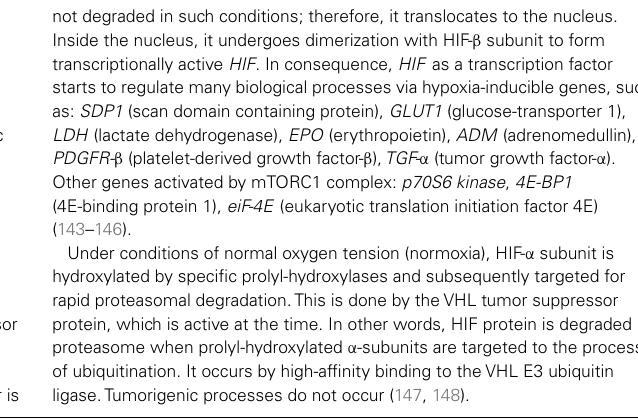
FIGURE 1 | Hypoxia inducible factor and VEGF link the HIF/VHL and PI3K/Akt/mTOR signaling pathways .Vascular endothelial growth factor, together with other external growth factors, activates Akt , which in turn activates mTORC1 complexThe PI3K (phosphoinositide 3-kinase) pathway may be overactive because of faulty or deficient phosphatase and tensin homolog ( PTEN ). mTORC1 is a protein complex that functions as a specific controller of protein synthesis. It is composed of mTOR itself, a regulatory-associated mTOR protein named Raptor, mammalian lethal with SEC13 protein 8 (MLST8) and G β L, a positive regulator of the rapamycin-sensitive pathway required for the nutrient-sensitive interaction between Raptor and mTOR.What is striking is that it has been shown that mTORC1 complex, when up-regulated, subsequently up-regulates the expression of HIF-1 α subunit (143–146). Under conditions of lower oxygen tension (hypoxia),VHL tumor suppressor protein becomes inactivated, which results in constitutive activation of the HIF pathway. HIF protein is heterodimeric; it consists of two constitutively expressed subunits: β -subunit and an oxygen-sensitive α -subunit.The latter is